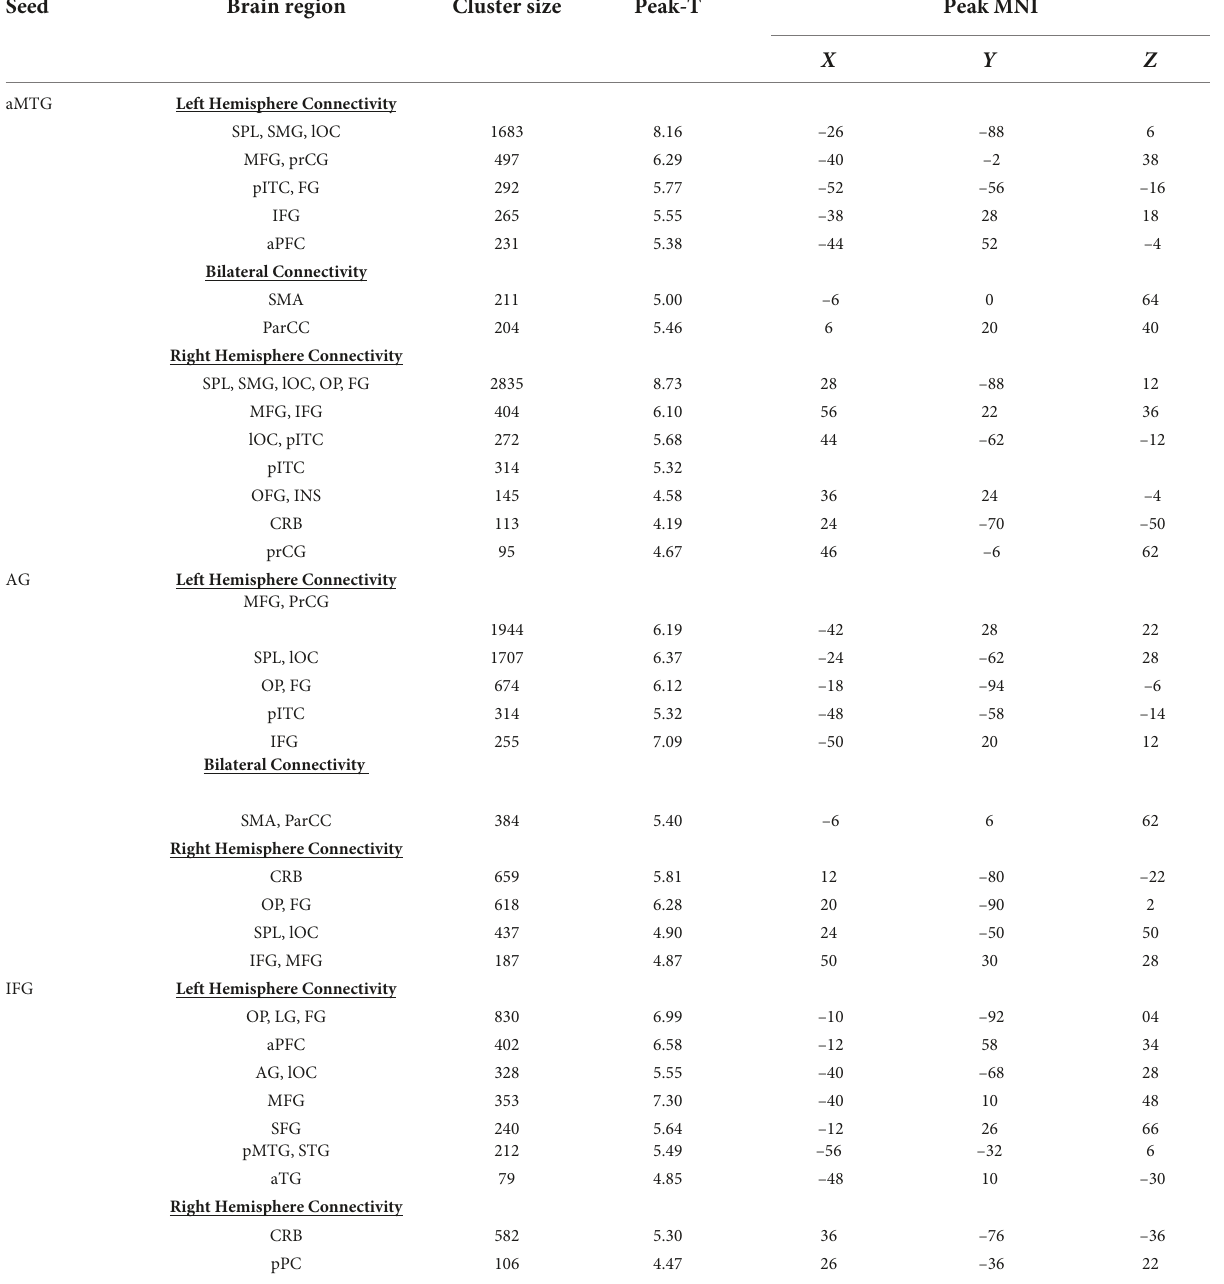
TABLE 2 Seed-to-voxel analyses for abstract word relative to rhyme processing.